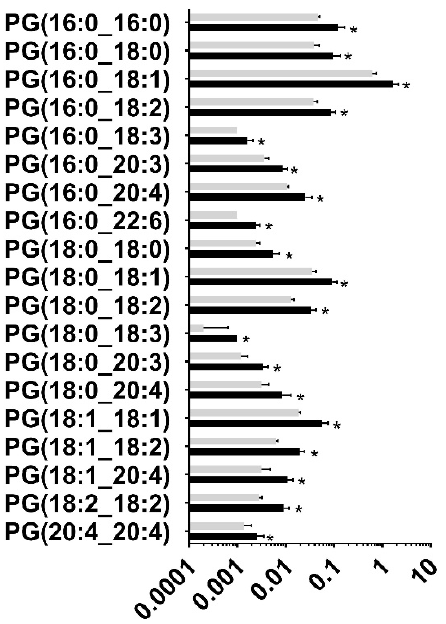
Figure 2. Significantly altered Phosphatidylglycerol subspecies in the maternal blood following gestational binge alcohol exposure. Targeted analysis of Phosphatidylglycerol (PG) was performed to identify PG levels in rat maternal blood following alcohol consumption during pregnancy. Nineteen subspecies were significantly altered ( p < 0.05) in maternal blood of the alcohol-administered rat. Interestingly, all 19 subspecies were upregulated in the maternal blood of alcohol-administered rats. *, p < 0.05.